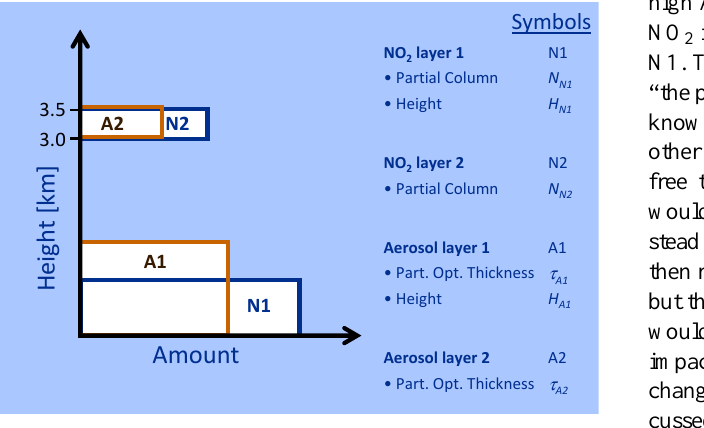
Fig. 2. Schematic description of the aerosol and NO 2 profile parametrization of the MAX-DOAS retrieval model used in this work. The conceptual model consists of an aerosol layer (A1) and a NO 2 layer (N1), which both go from the surface to a variable height, optionally extended with one or two second layers: A2 and N2, placed at a fixed altitude (3–3.5km). The retrieval model thus has a minimum of four and a maximum of six free parameters. The use of the two optional layers (A2 and N2) is studied in Sect.